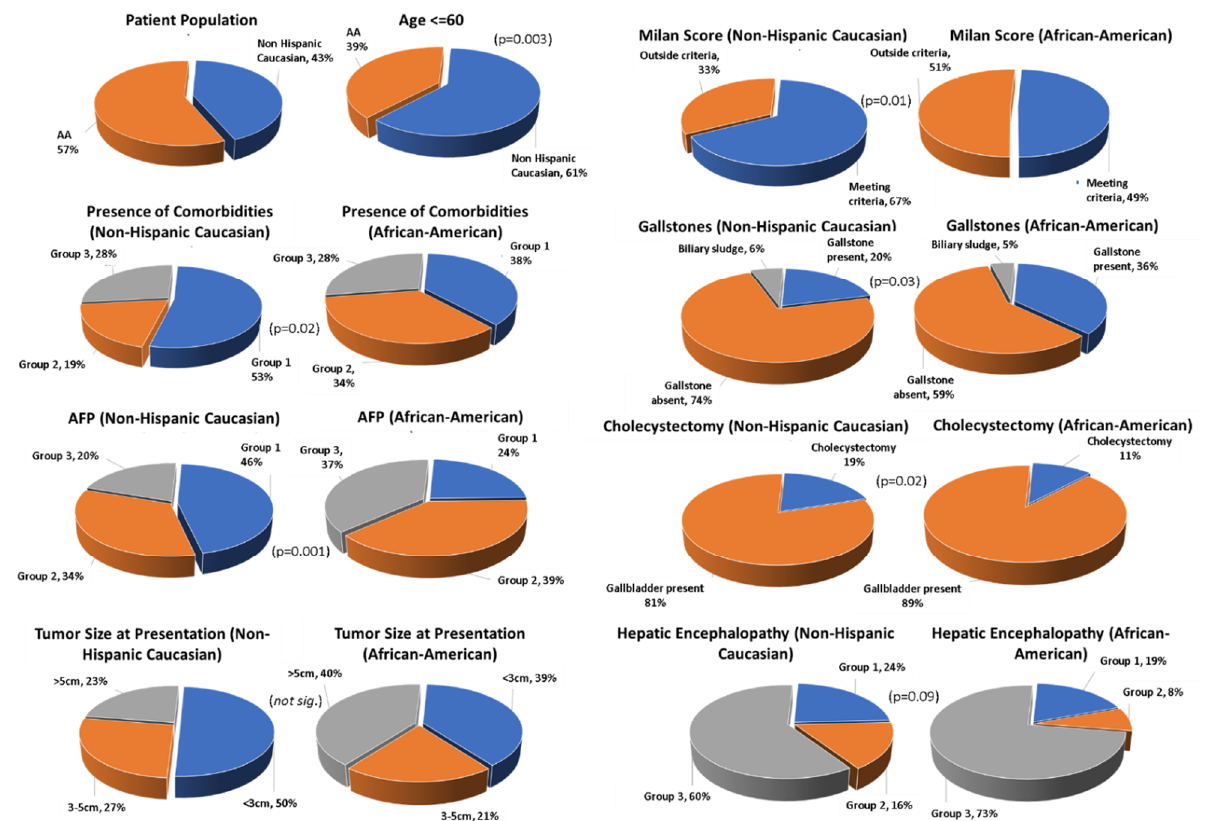
Figure 1. Differences between Caucasian and African American (AA) populations and disease presentation in HCC. Graphical data are summarized from results Section 3. Shown are p -values or non-significance (not. sig.). Left panel: African American vs. Caucasian group representation, age, presence of co-morbidities, AFP values, and tumor size at presentation. Right panel: Milan score, presence of gallstones, cholecystectomy, and hepatic encephalopathy.